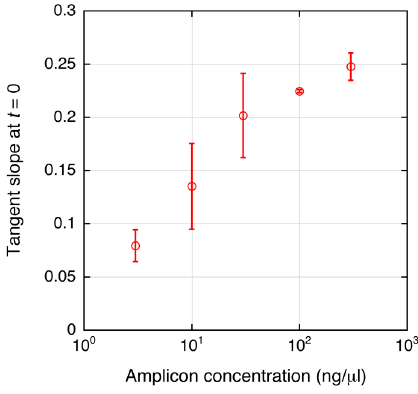
Figure 5. Relationship between amplicon concentration and the tangent slope of the DEPIM curve. PCR-amplified 391-bp DNA was used to evaluate the relationship. Mean values are shown; error bars are the standard deviation from 2 to 4 independent experiments.